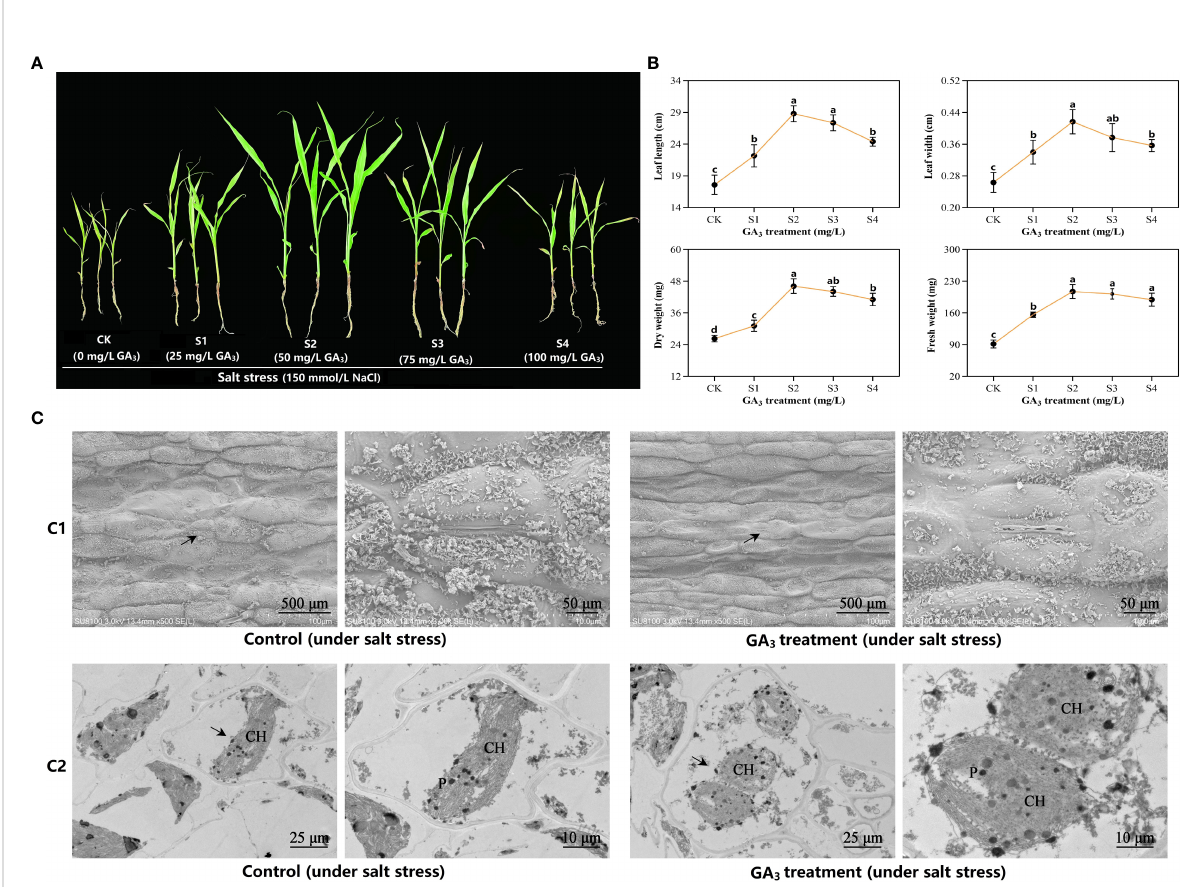
FIGURE 1 Sorghum phenotypic and leaf ultrastructure differences after exposure to exogenous gibberellic acid (GA 3 ) under salt-stress. (A) Phenotypic observation. All sorghum plants were exposed to 150 mM NaCl to induce salt stress. CK refers to the control plants under salt stress. S1 – S4 denotes the experimental leaves with 25 mg/L GA 3 , 50 mg/L GA 3 , 75 mg/L GA 3 , and 100 mg/L GA 3 exposure, respectively, under salt stress. (B) Morphologic variations. Six sorghum plants were selected from the GA 3 -treated (n= 3) and control groups (n= 3) for morphologic evaluation, which included assessment of the plant leaf width, leaf length, as well as fresh and dry weights. All data are provided as mean ± SD, and Superscript distinct small letters represent a marked difference ( p < 0.05), whereas, superscript same small letters represent no obvious difference ( p > 0.05). (C) The 50 mg/L GA 3 -mediated regulation of sorghum leaf anatomical structure under salt stress. C1 — epidermal structure and stomatal status; C2 — cellular ultrastructure. The fi gure on the right is an enlarged vision of the black arrow-labeled area on the left. CH, chloroplast; P,